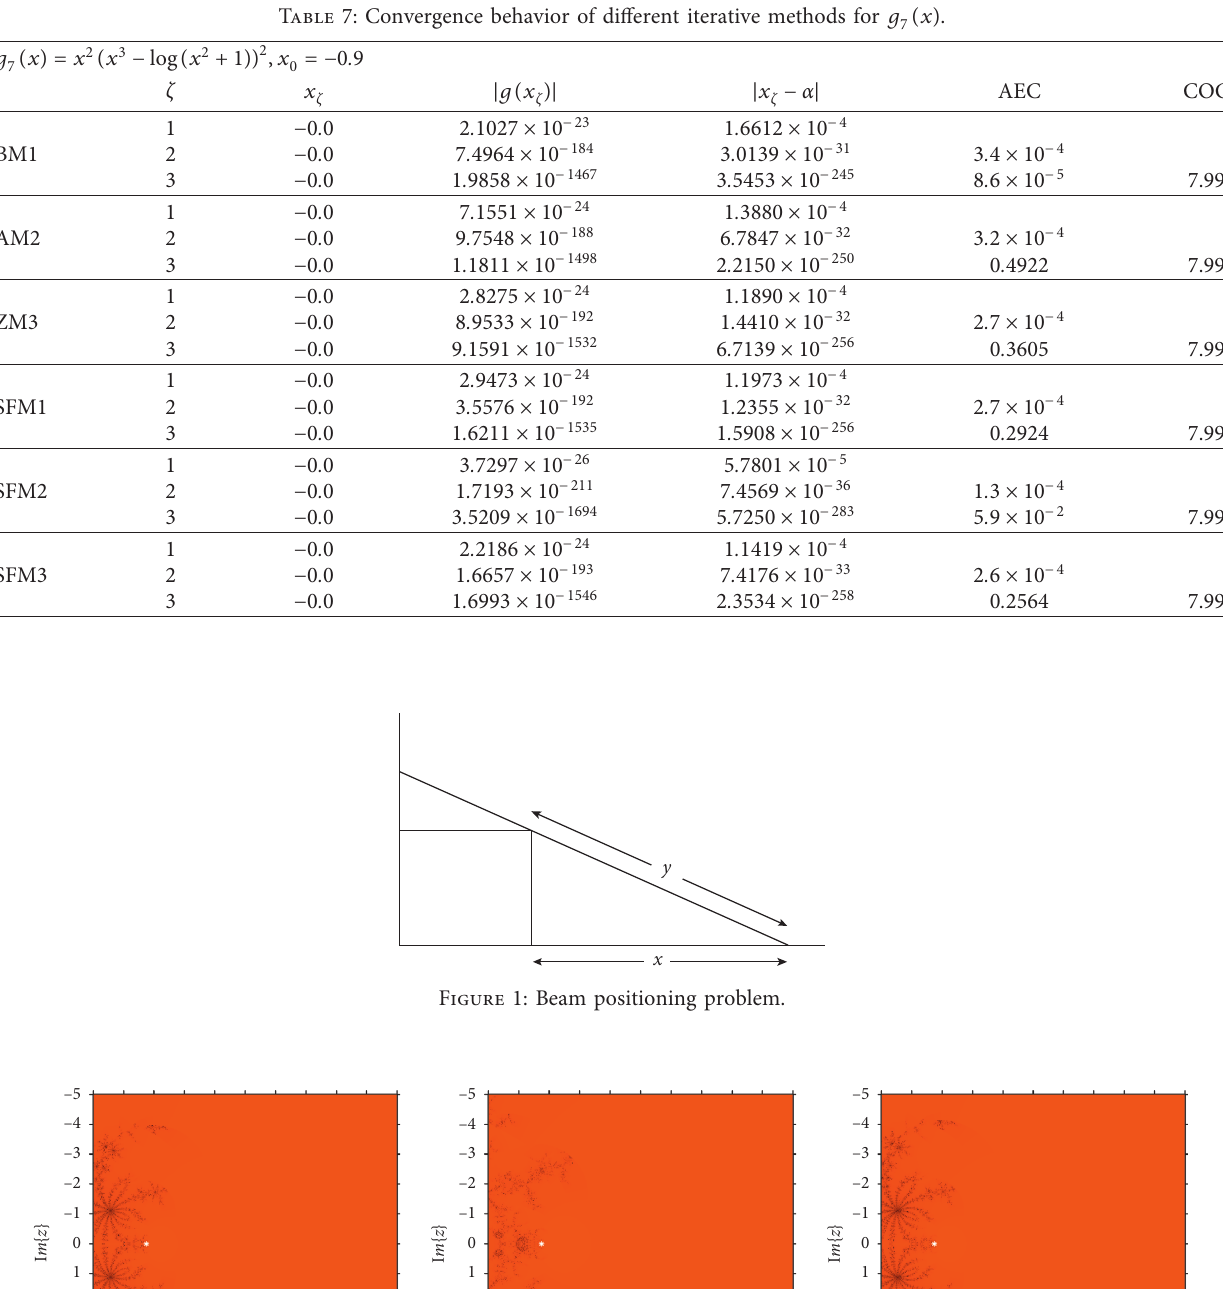
Table 7: Convergence behavior of different iterative methods for g